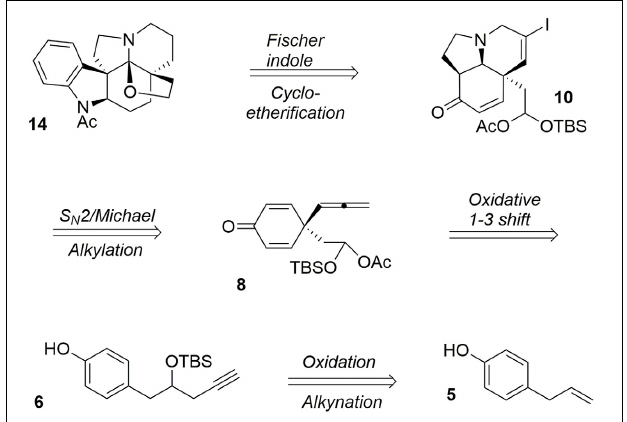
FIGURE 3 | Retrosynthesis of